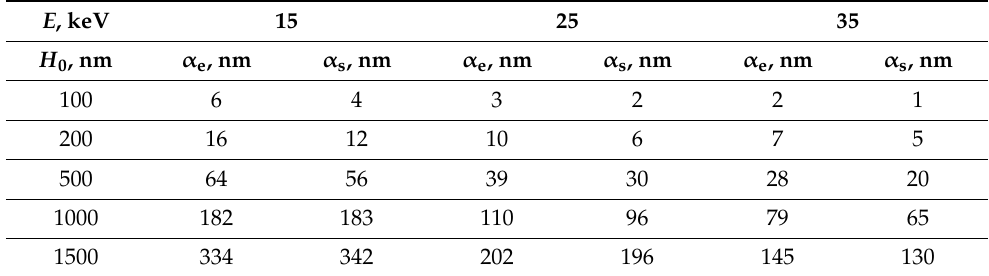
Table 1. Comparison of the parameters of the proximity function α s, (obtained by the method described above based on the Monte Carlo calculation) and α e, (calculated from the results of interpolation of experimental data [21]), for three values of the electron energy E and different thicknesses H 0 of the PMMA resist. The substrate is